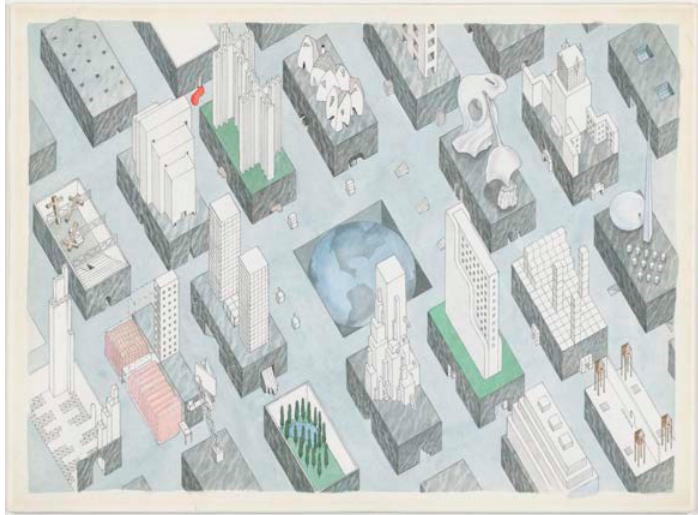
Figure 9. Rem Koolhaas, The City of the Captive Globe Project, 1972.